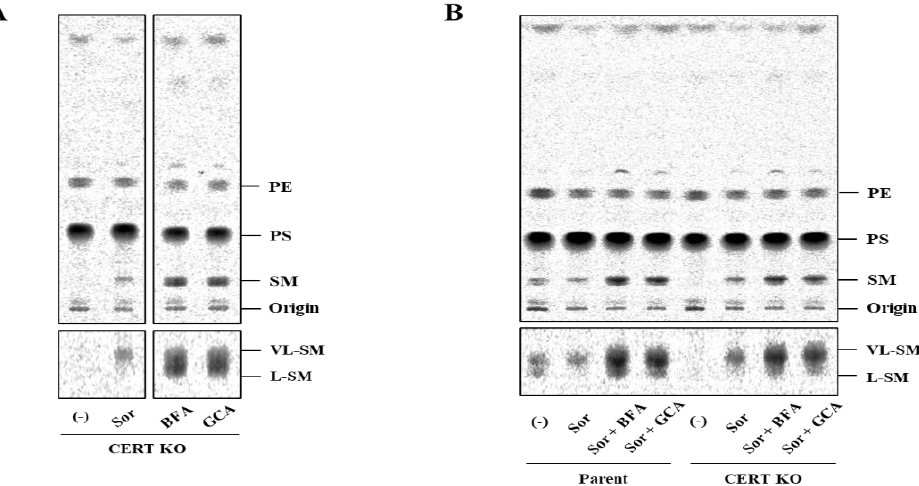
Figure 5. Effect of pharmacological merging of the Golgi apparatus with the ER on hyperosmotic stress-evoked VL-SM synthesis. ( A ) CERT KO cells were labeled with [ 14 C]-serine/800 mM sorbitol, 2.5 µM BFA, 20 µM GCA-containing medium, or normal culture medium for 1 h. Metabolically labeled lipids were analyzed by TLC. The representative cropped TLC images on the same plate (the upper panels), and vertically magnified images of the SM (the lower panels) to discern the doublet, are aligned. Two independent experiments were carried out, and similar results were obtained. ( B ) Cells were labeled with [ 14 C]-serine in an 800 mM sorbitol-containing medium in the presence of 2.5 µM BFA or 20 µM GCA. Metabolically labeled lipids were analyzed by TLC. The representative whole TLC image (the upper panel) and magnified image of the SM doublets (the lower panel) are shown. Two independent experiments were carried out, and similar results were obtained.